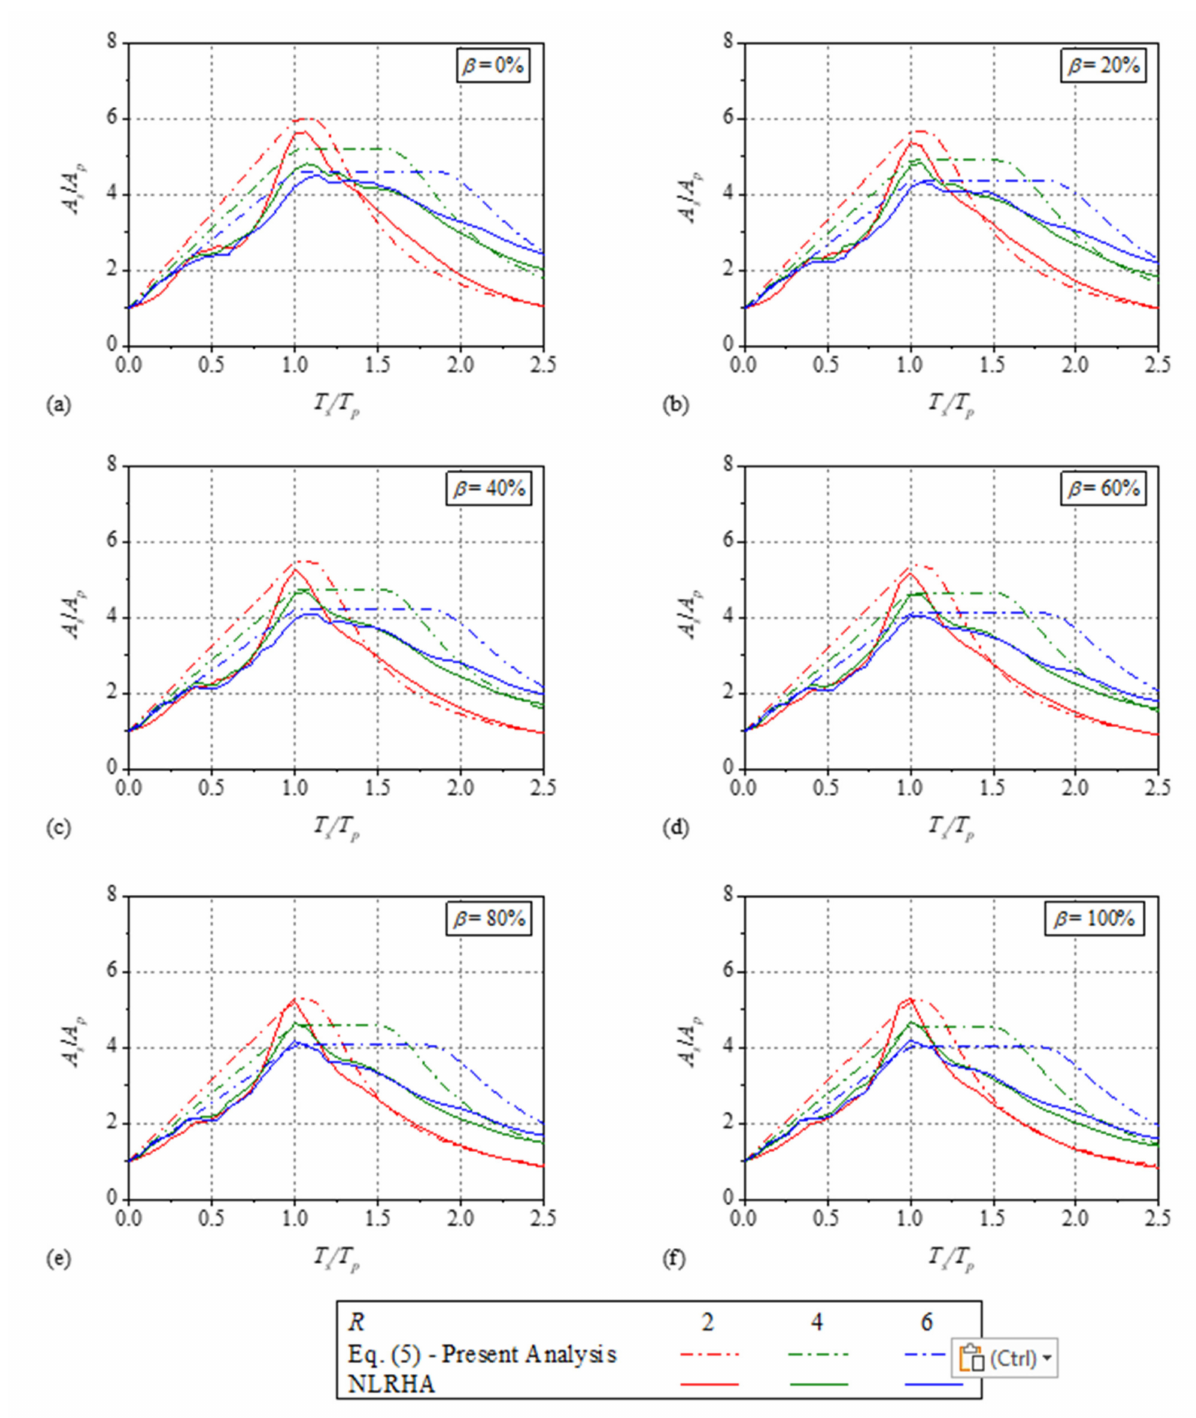
Figure A3. Comparison of the mean normalized floor response spectra from Equation (5) and for a primary structure with initial vibration period T p = 1.5 s: ( a ) β = 0%; ( b ) β = 20%; ( c ) β = 40%; ( d ) β = 60%; ( e ) β = 80%; and ( f ) β =